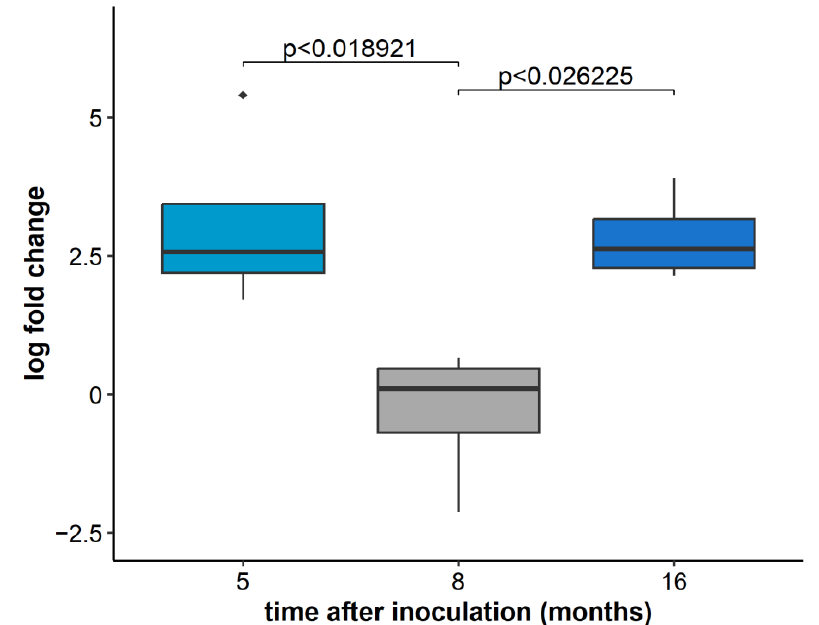
Figure 2. The relative concentration of GLRaV-3 based on ORF1a analysis five, eight months, and 16 months after inoculation observed in plants of all varieties harboring GLRaV-3 only (inoculum II). Results are displayed as logarithmic ratios of relative concentration. ANOVA test was performed along with the Bonferroni post hoc test and significantly different values ( p < 0.05) are marked above individual box plots. Outlier measurements that are 1.5 times over the upper/lower quartile of the dataset of an individual boxplot are marked with ◆ .